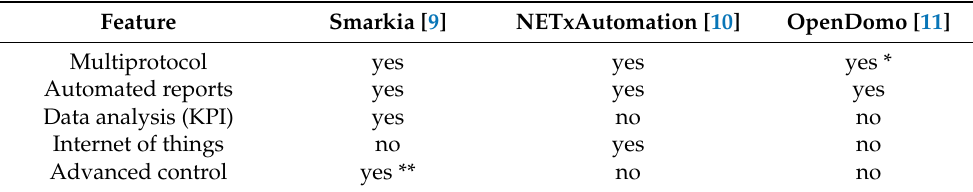
Table 1. Comparison of three commercial examples for BEMS